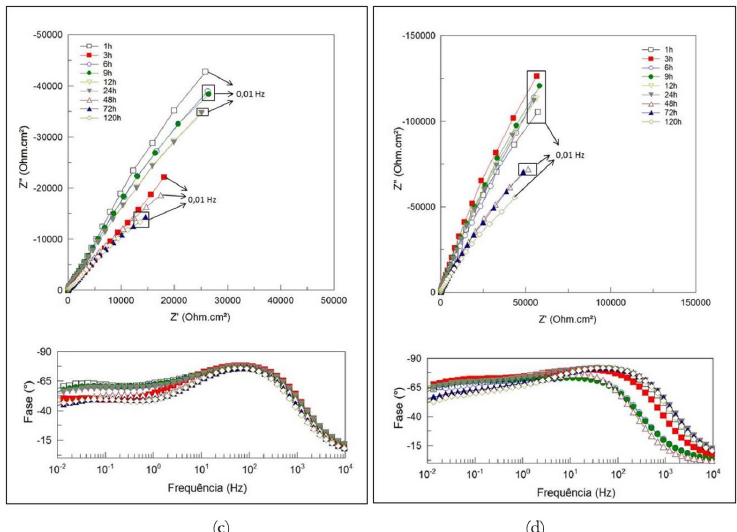
(Continuation) Figure 4. Nyquist and phase angle diagrams (φ versus log f) with immersion time for CA -50 steel in pore water: (a) AP1 + 1.0% NaCl (common Portland cement [17]). (b) AP2 + 1.0% NaCl (blast furnace slag [17]). (c) 75CPV25EA